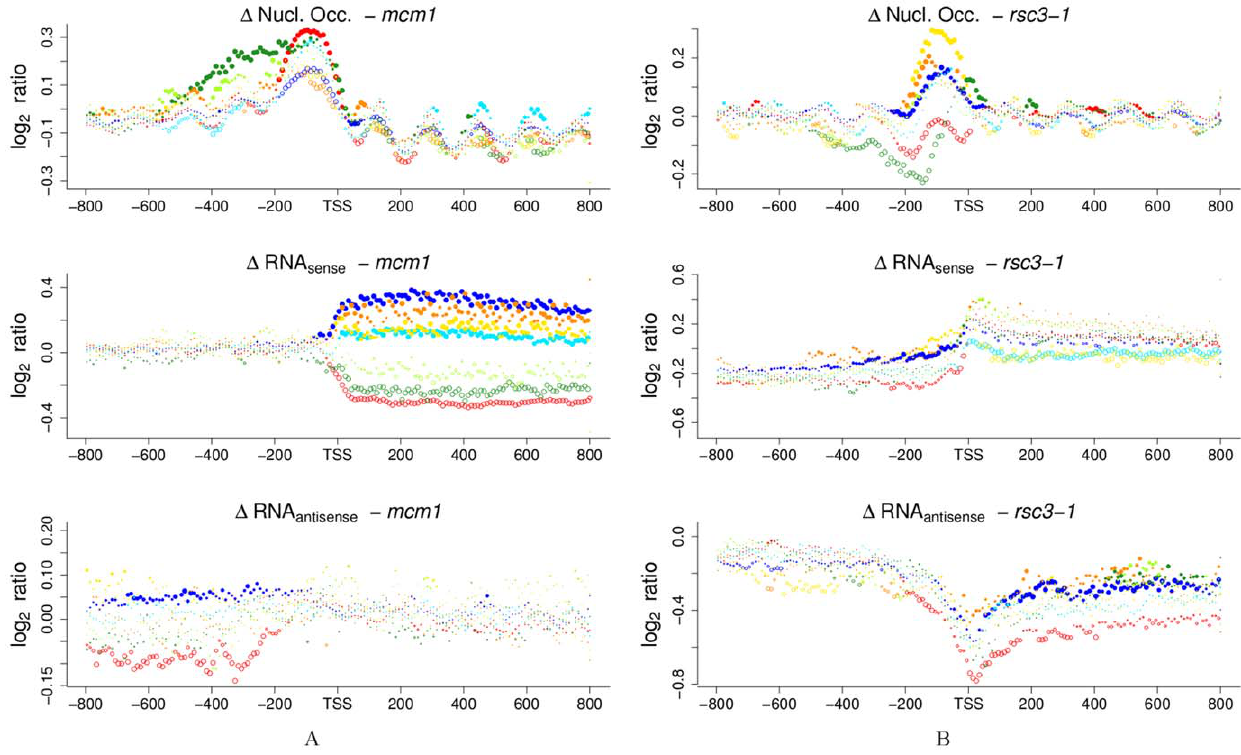
Figure 6. Changes in nucleosome occupancy and transcription in mcm1-1 and rsc3-1 strains. SDP plots were constructed as described for Figure 4. Figure 1C provides a color legend. All data are from [41] and were provided (by the original authors) as shown, i .e., D ~ log 2 are the processed signal intensities from the individual experiments in mutant and isogenic control strains. In all figures, the top panel shows change of nucleosome occupancy from tiling arrays in 4 bp resolution, the middle and bottom panels show the change in transcriptome tiling array signal in 8 bp resolution from the sense and the antisense strands, respectively. 6A: mcm1-1 ; 6B: rsc3-1 . Results for background clusters are shown in Figures S13 & S18.